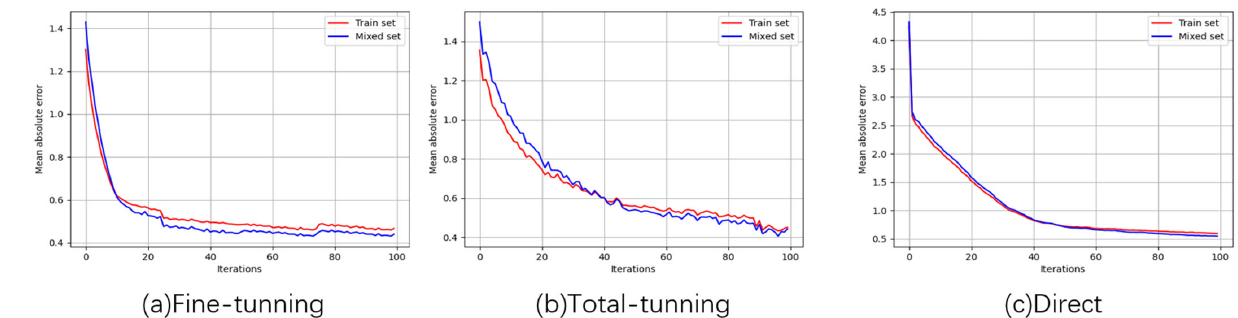
Figure 3. The changes of MAE in deep learning-based model training. ( a ) is the process of fine-tuning; ( b ) shows the variation of MAE in total-tuning training; ( c ) shows the MAE changes of direct.